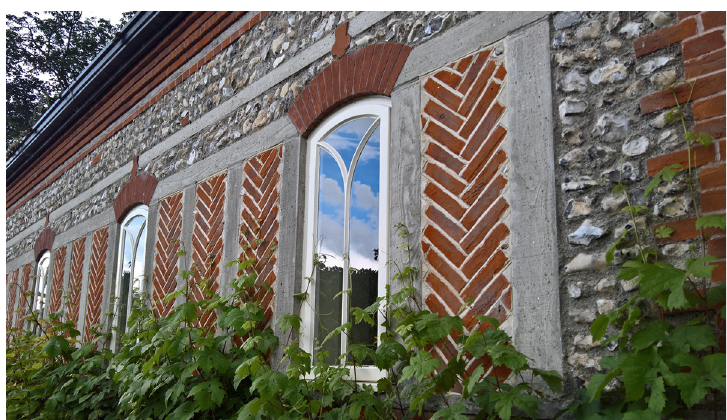
Figure 5. Fine structure at West Dean. Source: [23].